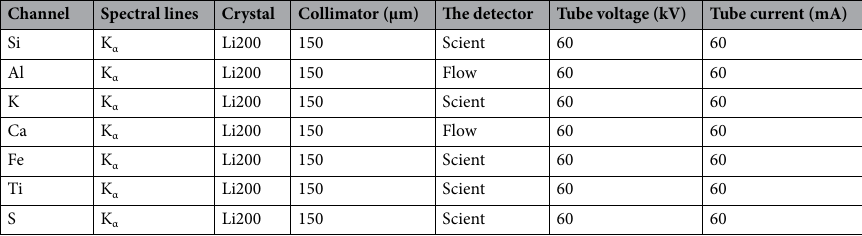
Table 1. Test conditions of wavelength dispersive X-ray fluorescence